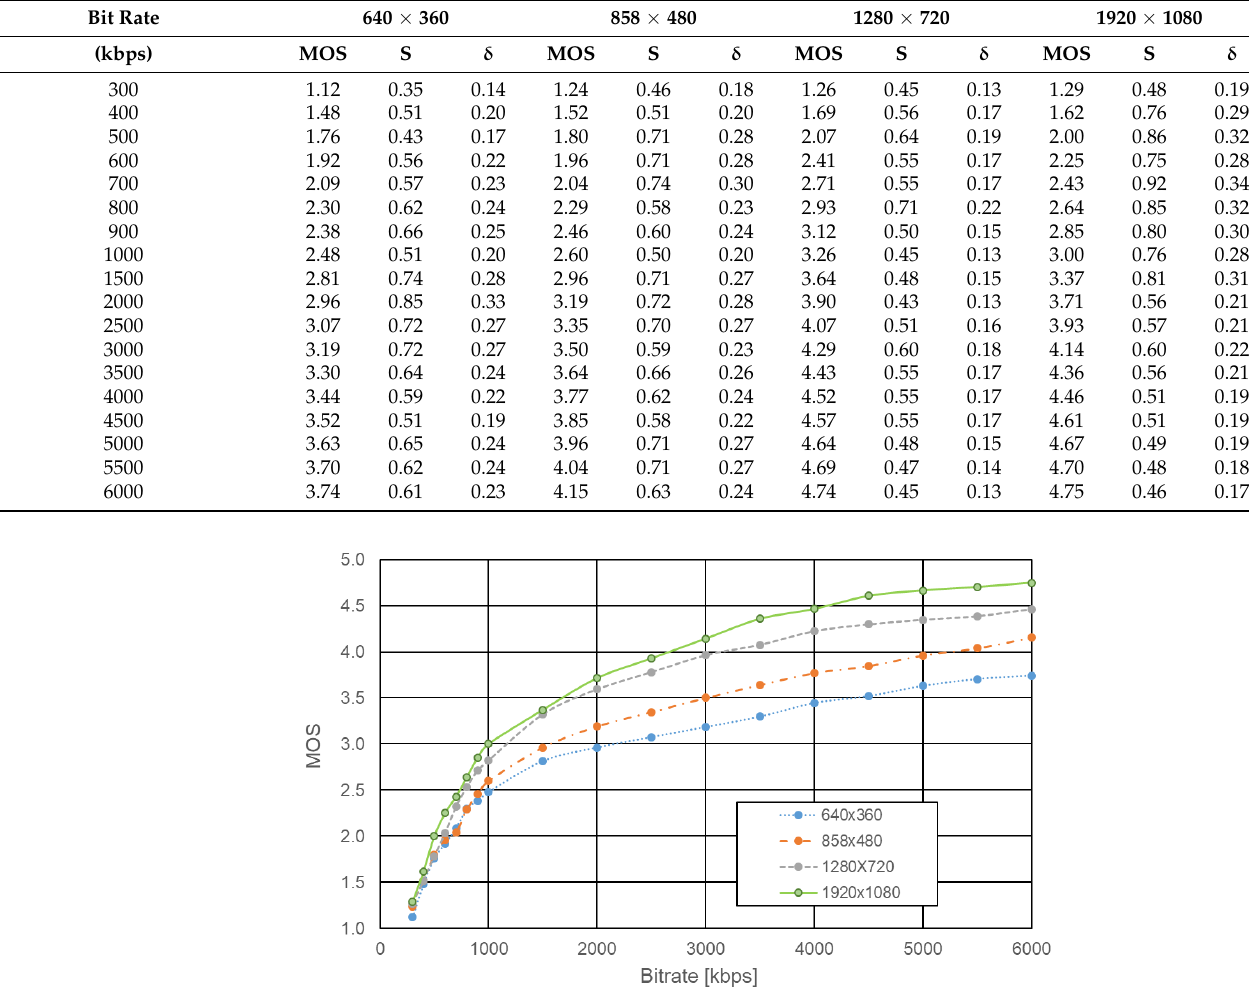
Figure 11. Results of the subjective quality assessment (MOS) for the VP9-encoded video as a function of bit rate for different spatial resolutions—measurements at home.